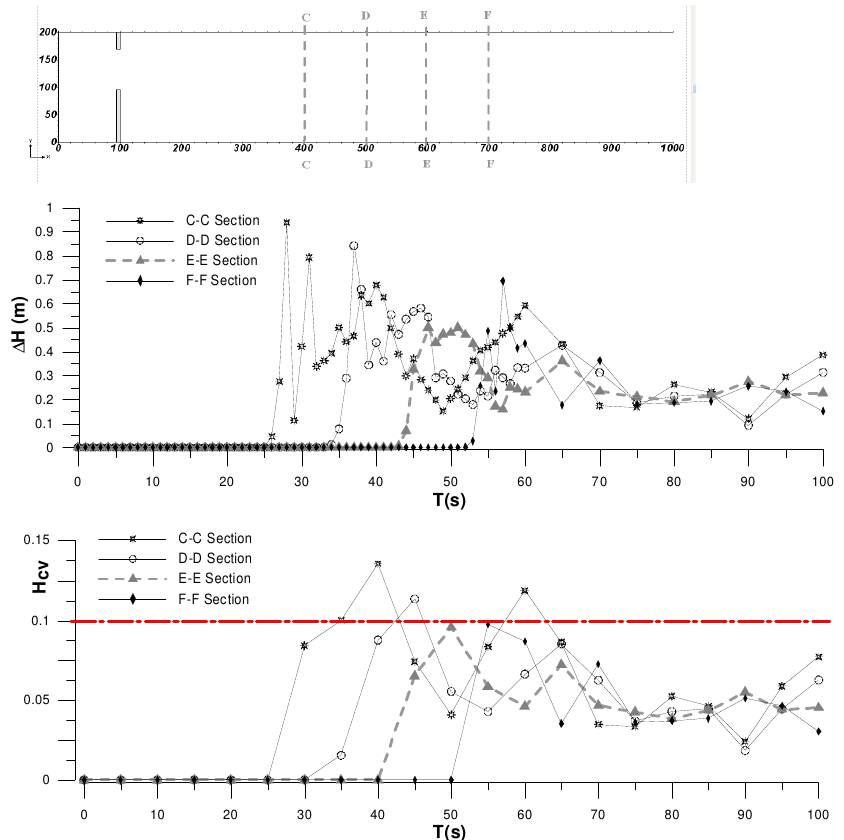
Fig. 6. 1h and Hcv depending on time at different cross Section: C-C (x=400), D-D(x=500), E-E(x=600), F-F (x=700).